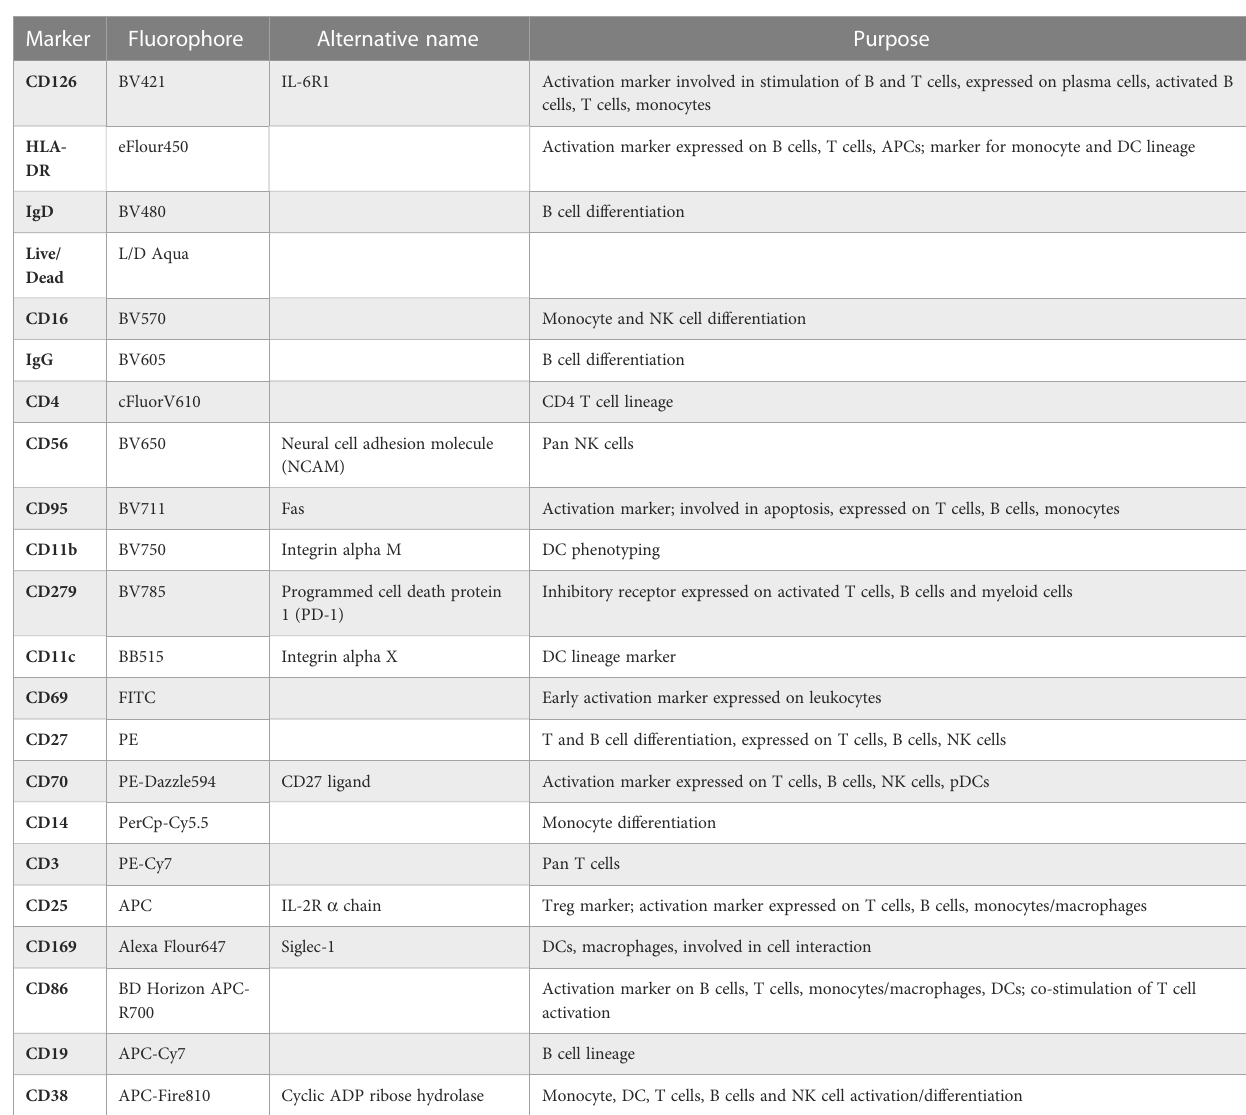
TABLE 1 Descriptive summary of PBMC